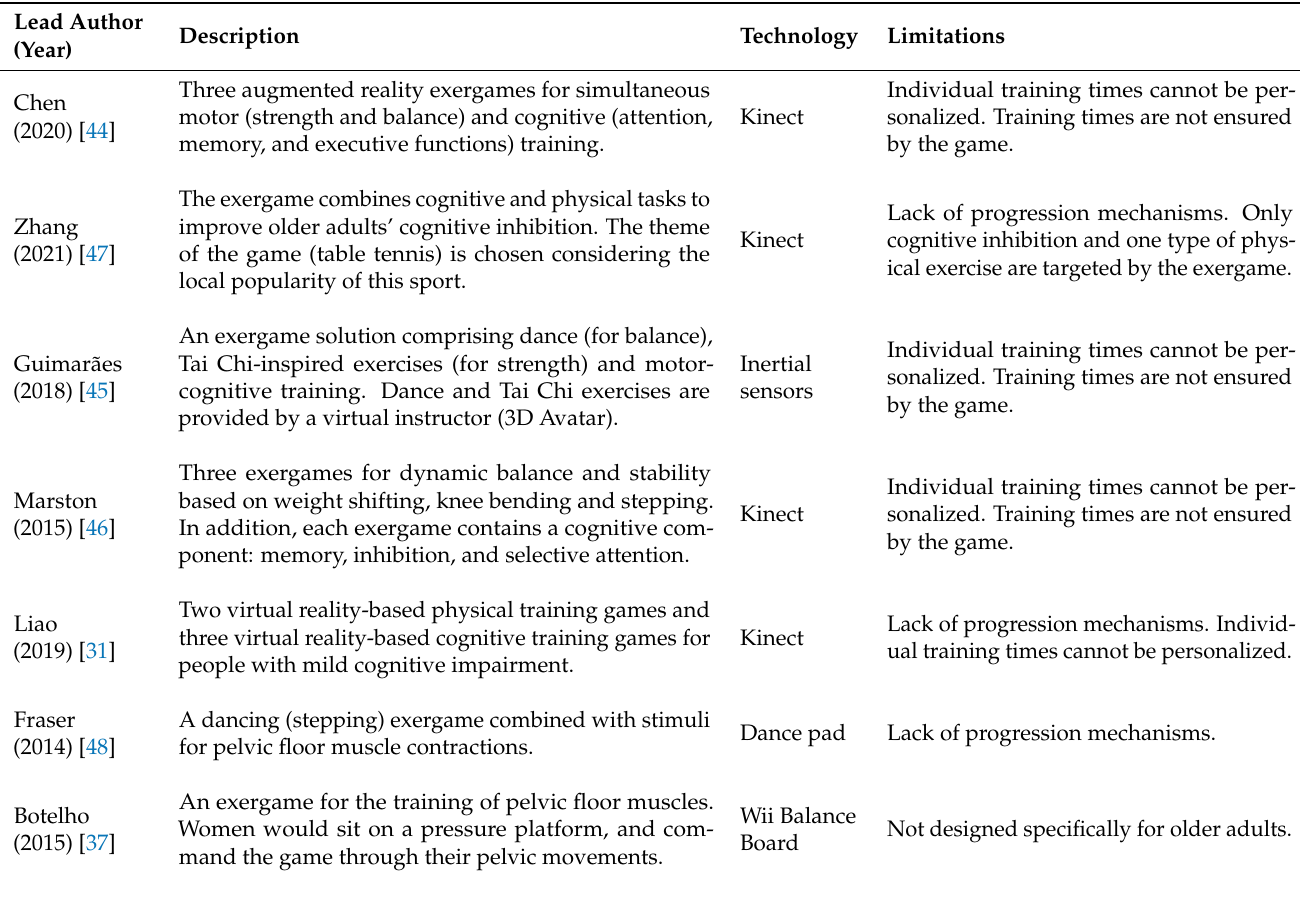
Table 1. Exergames for motor-cognitive and pelvic floor muscle training in older